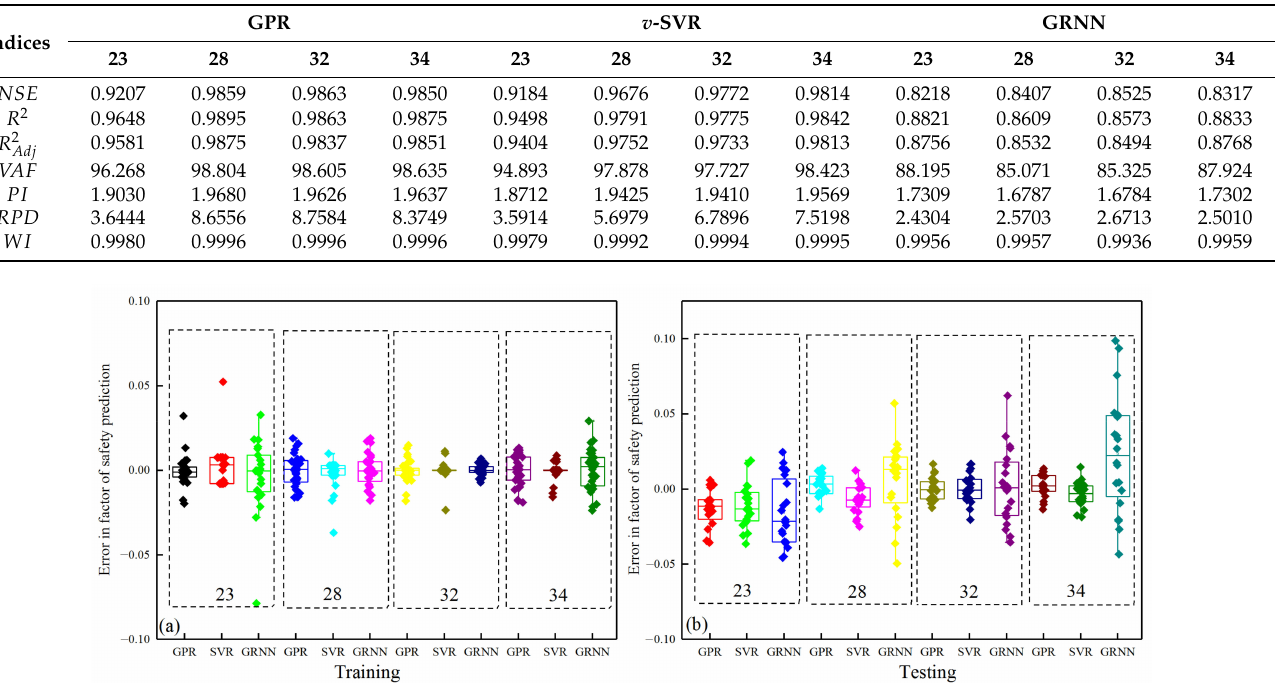
Table 9. Model accuracy of GPR, v -SVR, and GRNN methods in Case 2.